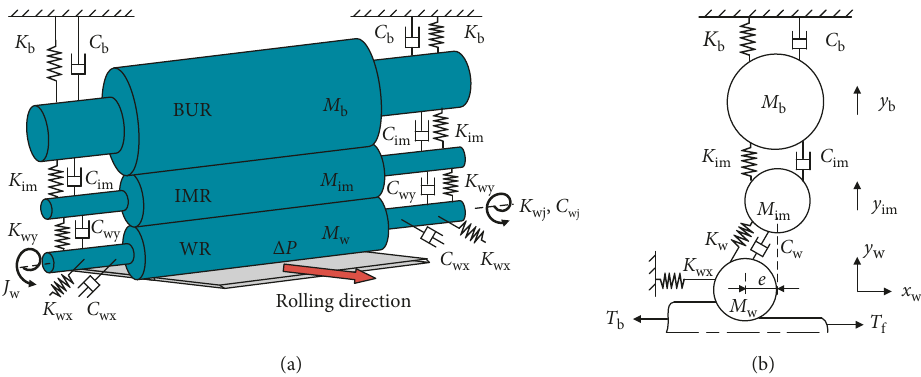
Figure 4: Geometry of the vertical-horizontal-torsional vibration model: (a) simplified vertical-horizontal-torsional coupled vibration model; (b) geometry of coupled vibration model in x-y direction.